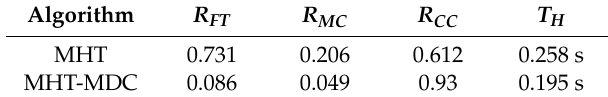
Table 2. The performance metrics of two algorithms in scenario 1.